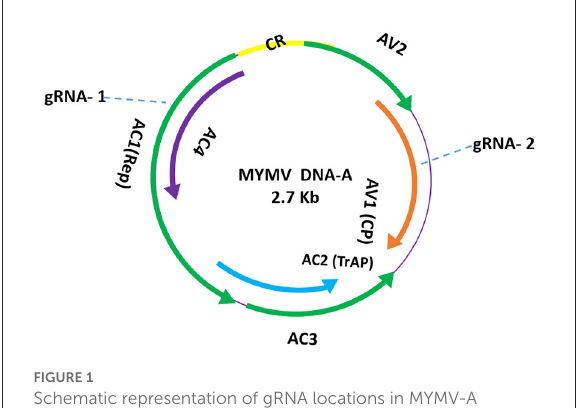
FIGURE1 Schematic representation of gRNA locations in MYMV-A genome. The gRNAs designed homologs to AC1- Rep protein and AV1- coat protein (target sites are indicated in dashed